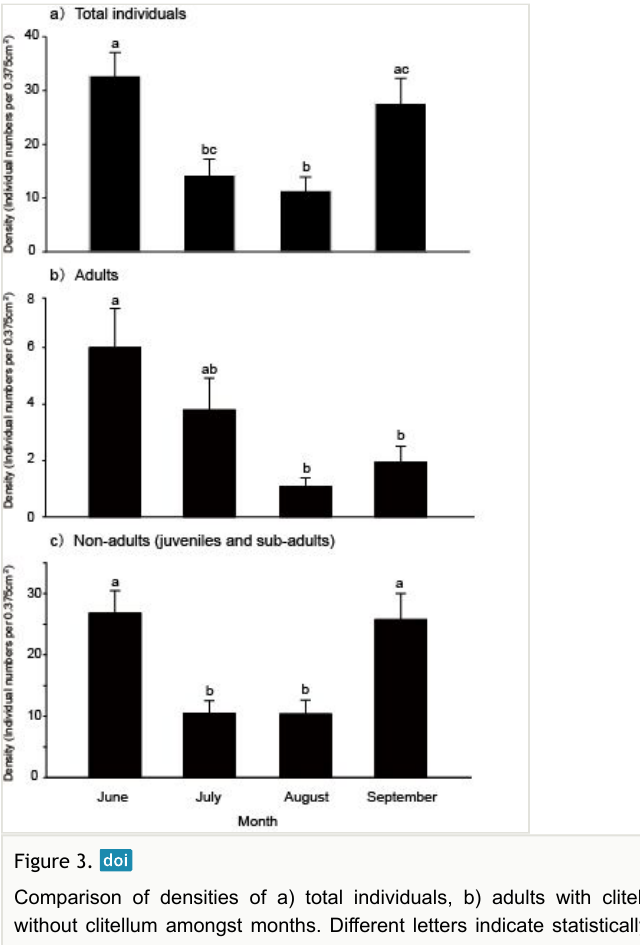
Figure 3. Comparison of densities of a) total individuals, b) adults with clitellum and c) non-adults without clitellum amongst months. Different letters indicate statistically-significant differences (p < However, in the present study, we observed that earthworm densities differed amongst regions. In particular, densities were high at the levees without adjacent forest, compared to levees with adjacent forests. The situation of farmland consolidation and characteristics in soil properties (Soil pH, C, N and C:N ratio) is unlikely to differ between these two types of levees (Table 1). Structures at margins between paddies and forests may reduce earthworm densities. Sklenicka et al. (2002) reported low porosity and infiltration rates in the soil in crop fields near forest edges and suggested that the phenomenon was caused by greater soil compaction, because the field boundaries are often used as corridors for agricultural machinery traffic. Alternatively, earthworm densities in levee grasslands with adjacent to forests may also be negatively affected by increased predation at the forest edge. For example, Andren (1992) found that the densities of corvid birds tended to increase in fragmented forests, as well as at the boundaries between forests and agricultural lands. Positive edge effects have also been documented for carabid beetles in